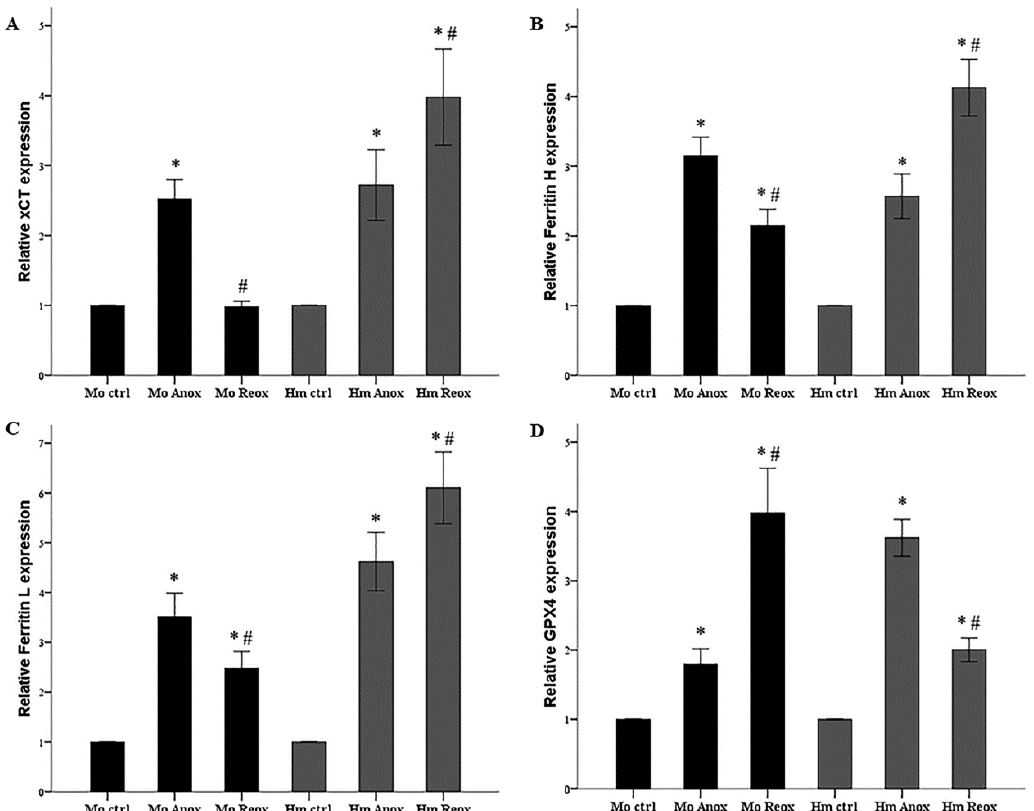
Figure 4. Expression of xCT, ferritin H, ferritin L and GPX4 in mouse and hamster RPTECs subjected to anoxia or reoxygenation. In mouse RPTECs, anoxia enhanced the levels of xCT, ferritin H, ferritin L, and GPX4 (panels A , B , C , and D respectively). During reoxygenation, at the time of the increased reactive oxygen species production, xCT, ferritin H, and ferritin L decreased, whereas GPX4 increased (panels A , B , C , and D respectively). In hamster RPTECs, anoxia also increased the levels of xCT, ferritin H, ferritin L, and GPX4 (panels A , B , C , and D respectively). However, reoxygenation raised xCT, ferritin H, and ferritin L further, but lowered GPX4 (panels A , B , C , and D respectively). These experiments were repeated nine times. Error bars correspond to SEM. Except for the asterisk (*) that detected the significance of GPX4 increase in mouse RPTECs in panel ( D ) and corresponds to a p < 0.05, in all other cases, the asterisk (*) corresponds to p < 0.001 when compared to the respective control cells and the hashtag (#) to p < 0.001 between cells subjected only to anoxia and cells subjected to anoxia followed by reoxygenation. Mo stands for mouse, Hm for hamster, ctrl for control, Anox for anoxia, and Reox for reoxygenation.